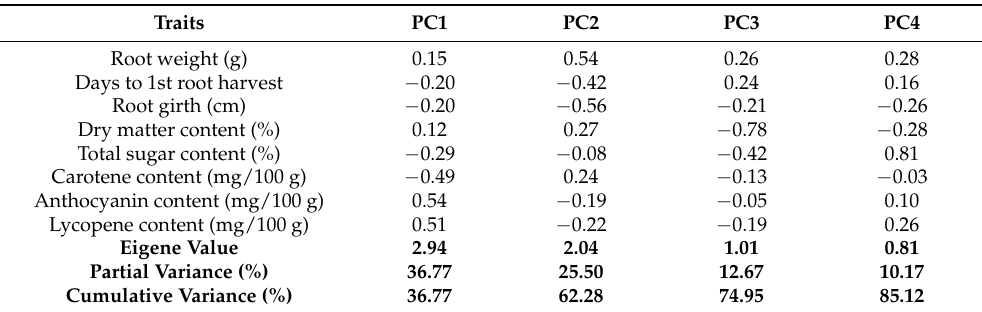
Table 6. Eigene Values, contribution of variance and factor loading for the Principal Component Analysis for different